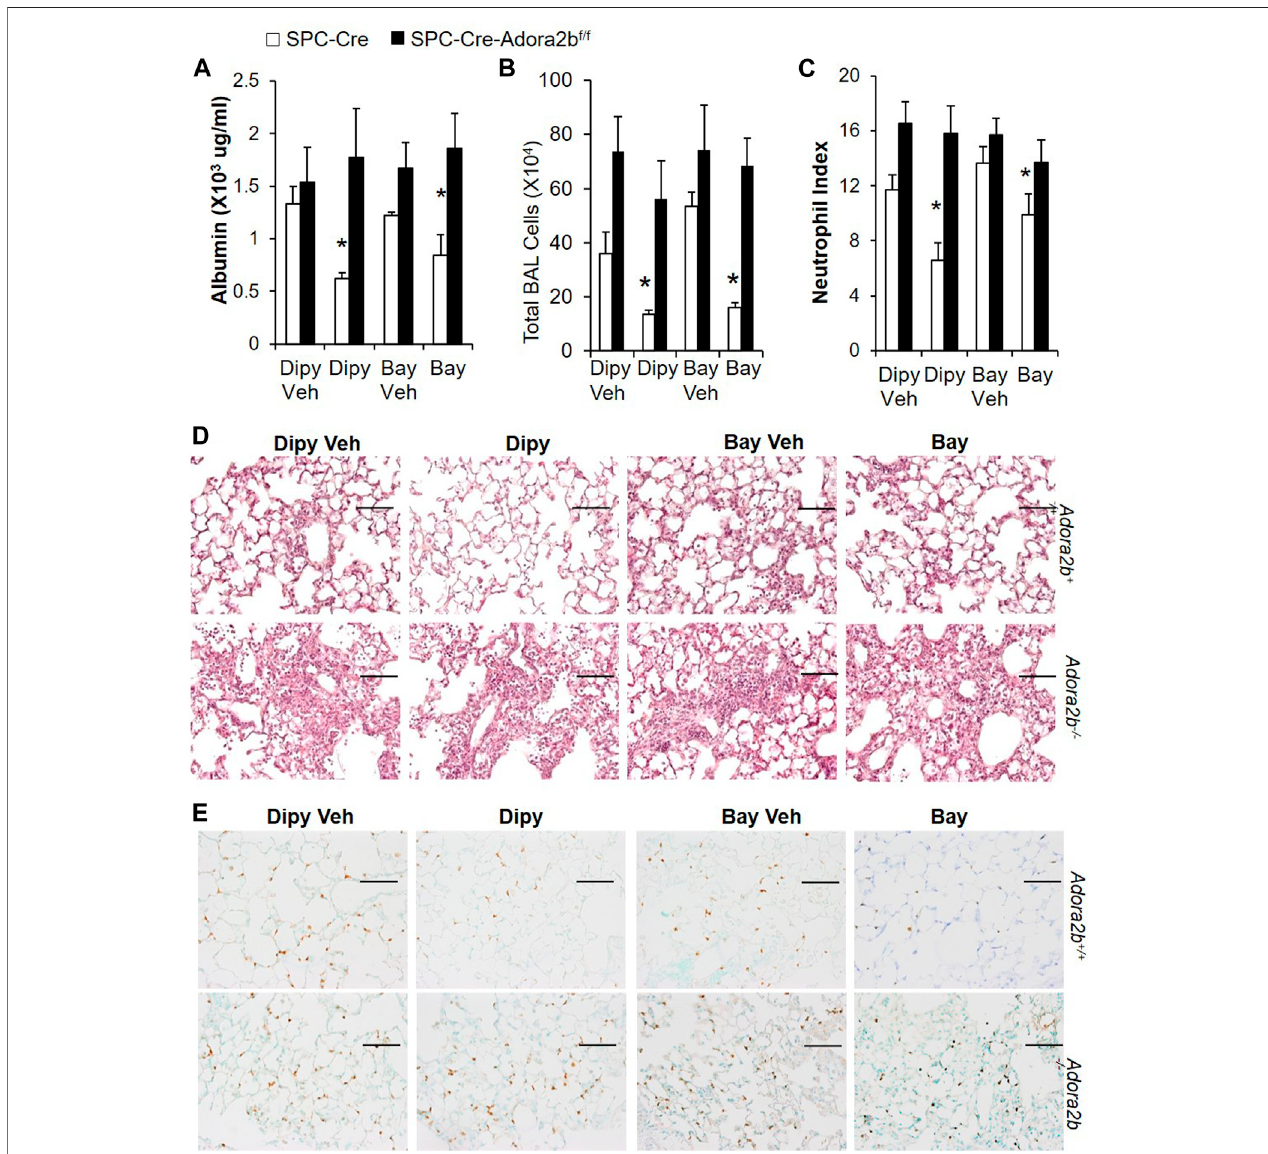
FIGURE 6 | Effect of Dipyridamole and BAY 60-6583 on established ALI in mice with Adora2b knockout speci fi cally in alveolar epithelial cells (SPC-Cre- Adora2blox/lox). SPC-Cre and SPC-Cre-Adora2blox/lox mice were treated with 2.5 U/kg bleomycin through i.t. Two days later, mice were treated with 5 mg/kg dipyridmole twice daily or 500 ug/kg BAY 60-6583 daily until day 7. BAL albumin (A) and total BAL cells (B) were measured. (C) Lung sections were stained with anti-Ly6B.2 for neutrophil index. (D) Representative H&E staining showed pulmonary in fl ammation and injury in various groups. (E) Representative lung sections stained with Ly6B.2 to show neutrophil in fi ltration. n (cid:2) 5, * p < 0.05 vs. vehicle using one way ANOVA followed by Bonferroni ’ s multiple comparisons test. Scale bar (cid:2) 100 µm.